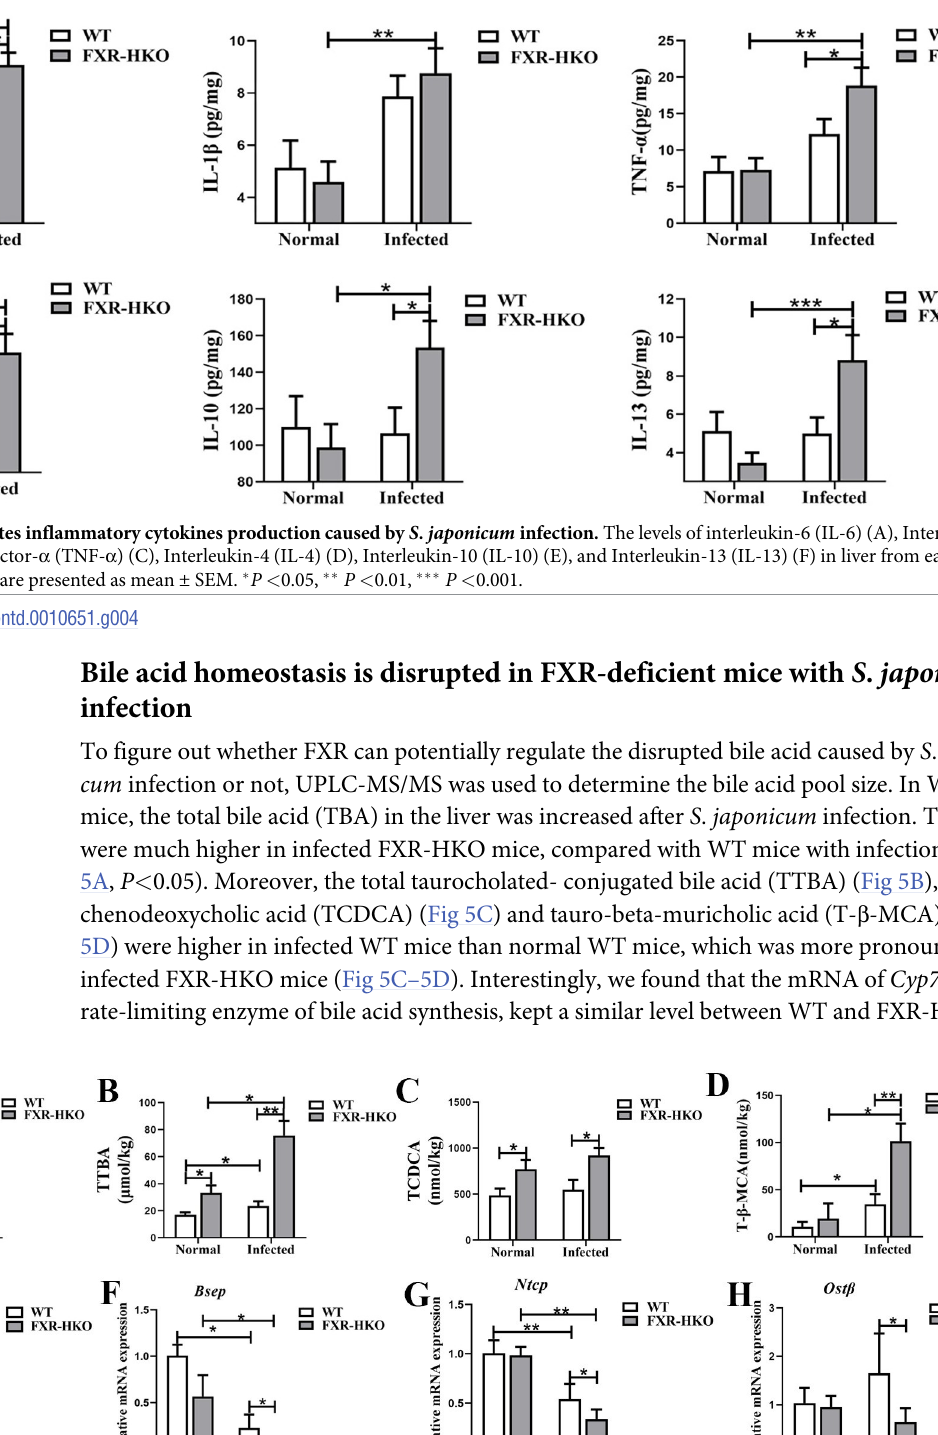
PLOS NeglectedTropical Diseases | https://doi.org/10.1371/journal.pntd.0010651 August 5,